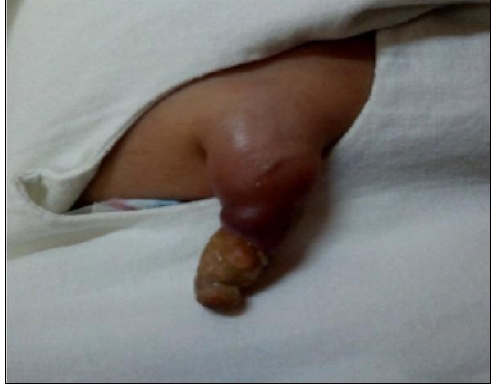
Figure 1: Umbilical hernia and epithelialized pulsatile cord with granulomatous tissue.